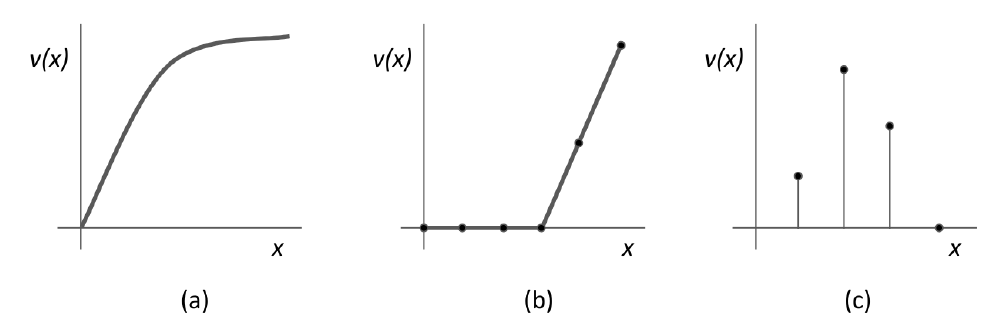
Figure 1. Examples of value functions: ( a ) a continuous value function that might hold, for example, for the value of one’s salary; ( b ) value function for an ordinal attribute, for example, for the value of car’s safety measured with NCAP points (in the example shown the user would be indifferent regarding values lower than 3); and ( c ) value function in case of a nominal attribute, such as